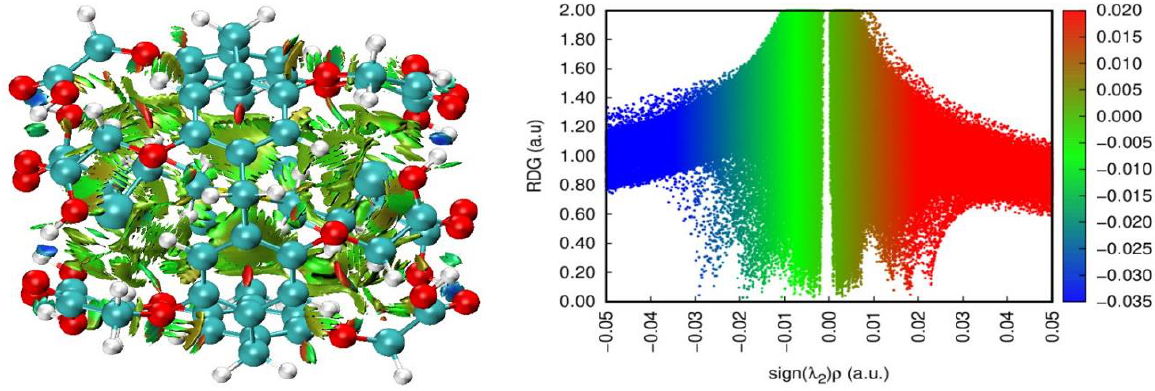
Figure 6. NCI-RDG isosurface (isovalue 0.5 a.u.) ( left ) and scatter plot ( right ) of SM@DCMP[5].